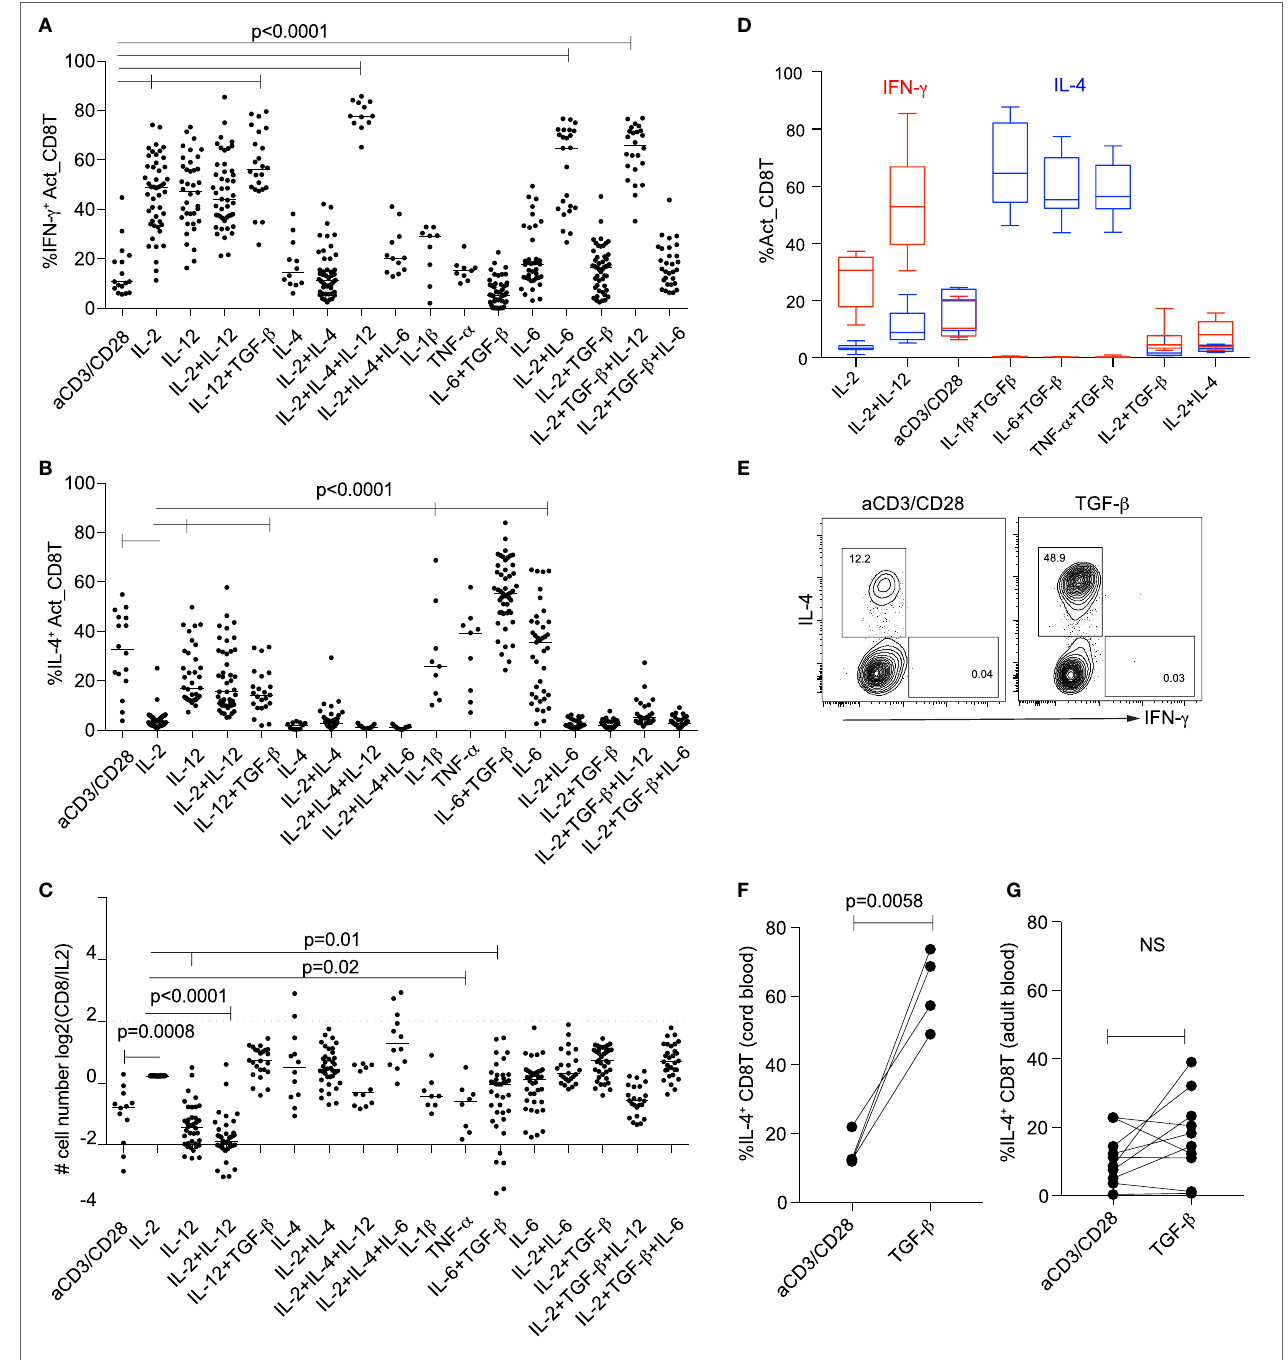
FigUre 2 | Differentiation of naïve cord blood CD8 + T cells is modified by different combinations of cytokines. Differentiation of cord blood CD8 + T cells activated with anti-CD3/CD28 microbeads (1:1) ± cytokines in different individuals. Proportions of CD8 + T cells expressing (a) IFN- γ or (B) IL-4 after cells were activated in the presence of different cytokines. (c) Numbers of cells generated when naïve CD8 + T cells were activated in the presence of different cytokines, relative to IL-2 alone. P -values between indicated groups were calculated by Kruskal–Wallis test and corrected for multiple comparison with Original FDR method of Benjamini and Hochberg. (D) Proportions of IFN- γ and IL-4-expressing CD8 + T cells after activation in the presence of inflammatory cytokines ( n = 10). Effects of activation and TGF- β on IL-4 expression for cord blood (e,F) and adult (g) CD8 + T cells. P -values calculated by paired t -test.